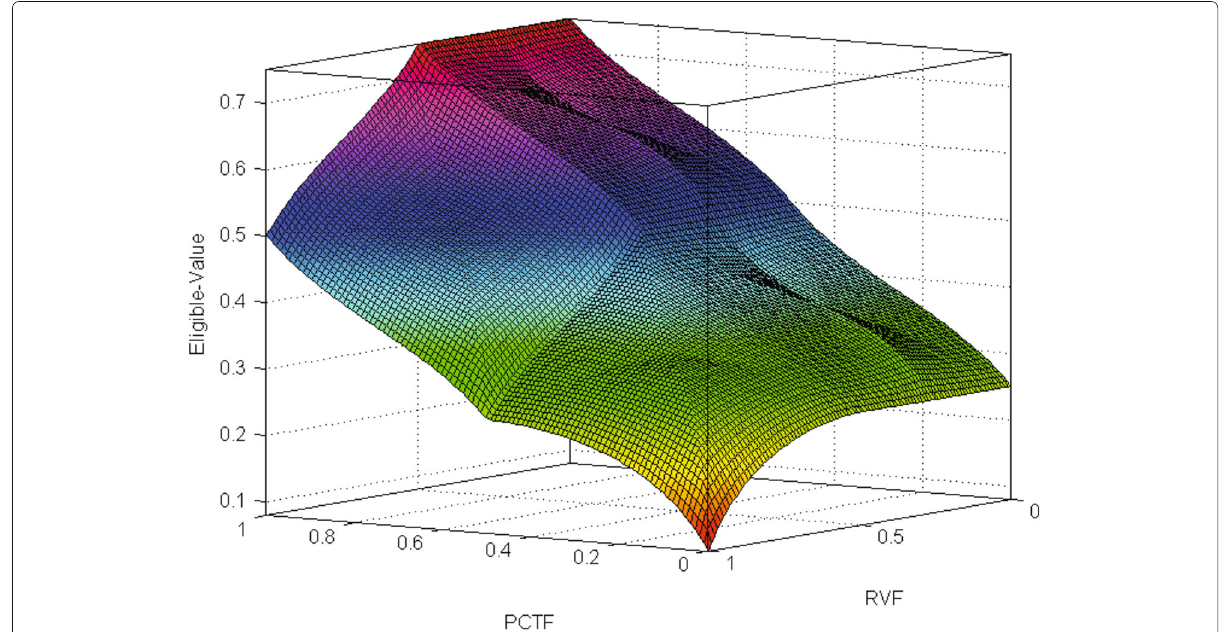
Fig. 11 Impact of RVF and PCTF on output